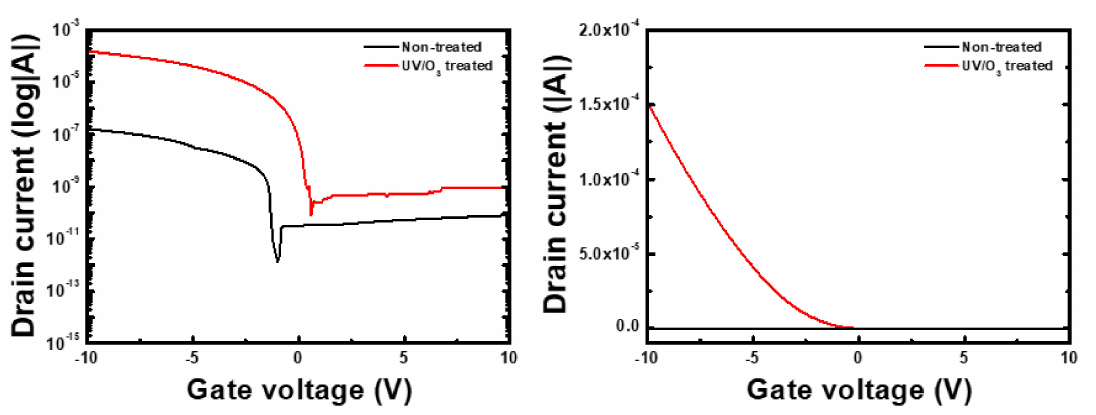
Figure 6. Measured I D -V G curves on log scale of Ga 2 O 3 /4H-SiC static induction transistor at V DS = 1